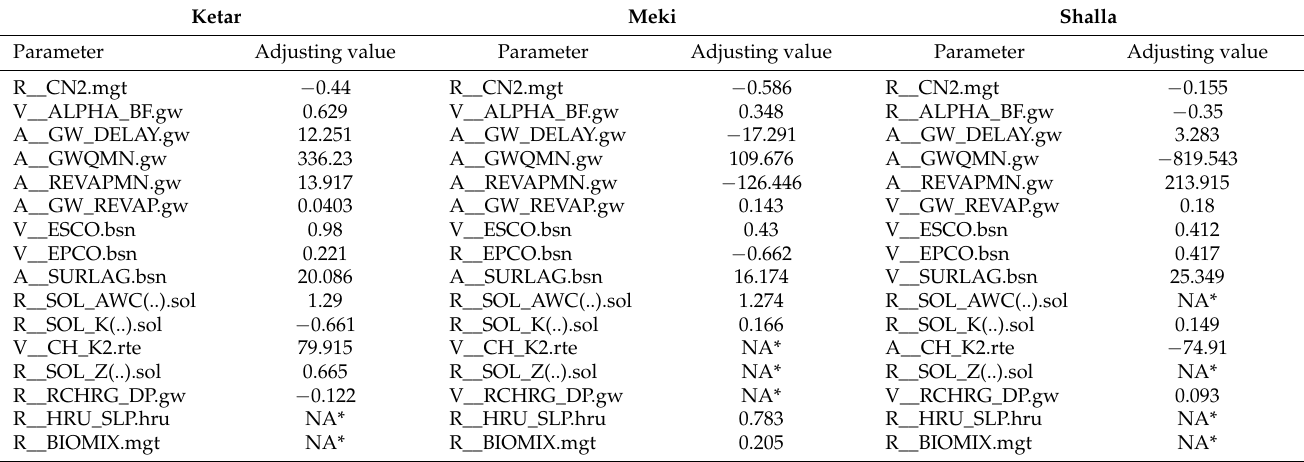
Table 4. Adjusting values and methods as adjusted by SWAT-CUP for the